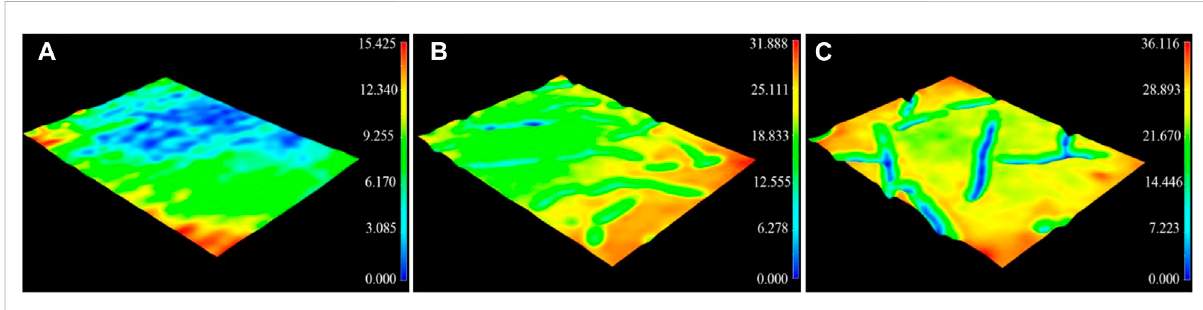
FIGURE 2 Three-dimensional laser pro fi le images of acrylate copolymer coating with R a of 0.175 μ m (A) , acrylate copolymer/0.25-SiO 2 NPs coating with R